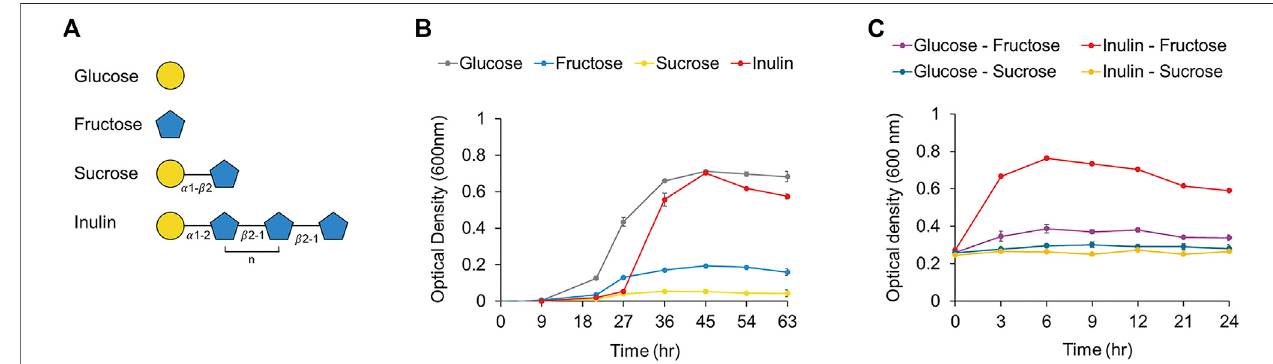
FIGURE7|(A) Structuresofthecomponents(i.e.,glucose,fructose,sucrose,inulin).ofinulinwereshown. (B) Thegrowthcurveof F.prausnitzii culturedinmYCFA supplemented with either glucose, fructose, sucrose, or inulin. (C) The growth curve of F. prausnitzii cultured in mYCFA supplemented with either fructose or sucrose. Cells cultured in inulin or glucose were harvested and inoculated in fructose or sucrose. Each point on the curves represents the average of three independent experiments. Error bars represent standard deviations (s.d.).